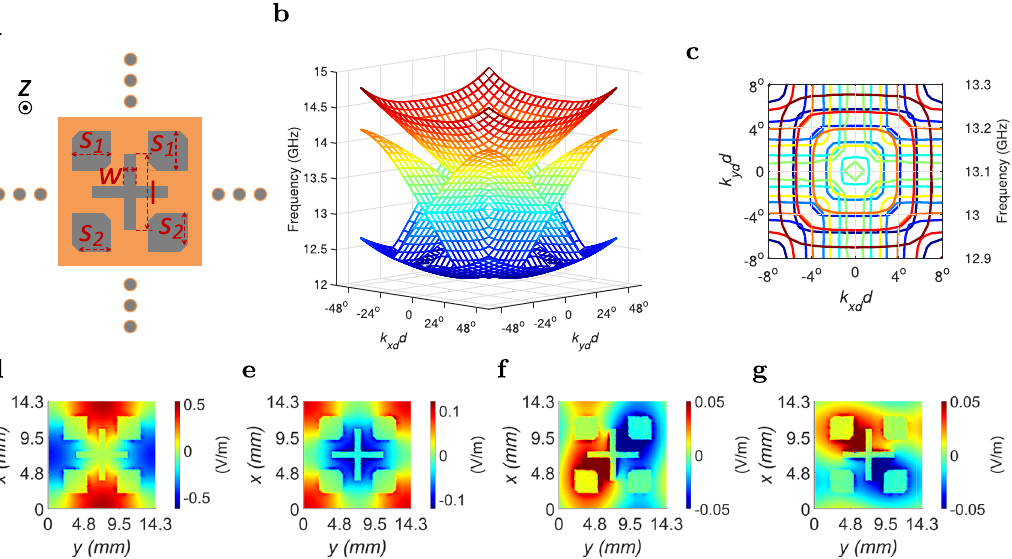
Fig. 2 Unit cell simulation. The specially engineered PEX array unit cell with a closed bandgap in the dispersion relation: a Top view of the unit cell showing the cross-shaped radiating slots, and the semi-square slots that are added to achieve accidental degeneracy between the eigenmodes, and close the bandgap at the Γ -point. b , c The corresponding full-wave simulated 2D dispersion relation and 2D dispersion contours showing a closed bandgap at the Γ - point. d – g The corresponding full-wave simulated electric fi eld distribution (V/m) of the 1st, 2nd, 3rd, and 4th eigenmodes at the Γ -point, respectively. (Dimensions: w = 1 mm, l = 7 mm, S 1 = 3.3 mm, S 2 = 2.7 mm and unit cell size = 14.3 mm × 14.3 mm × 1.575 Fig. 2d – g. Noticeably, the electric fi eld distributions around the cross-shaped slots are antisymmetric, especially for the 3rd and 4th eigenmodes, making the unit cell capable of achieving suc- cessful radiation (leakage) from the underlying electric fi eld. More details about the process of designing and optimizing the unit cell, and closing the bandgap are discussed in the “ Methods ” section.